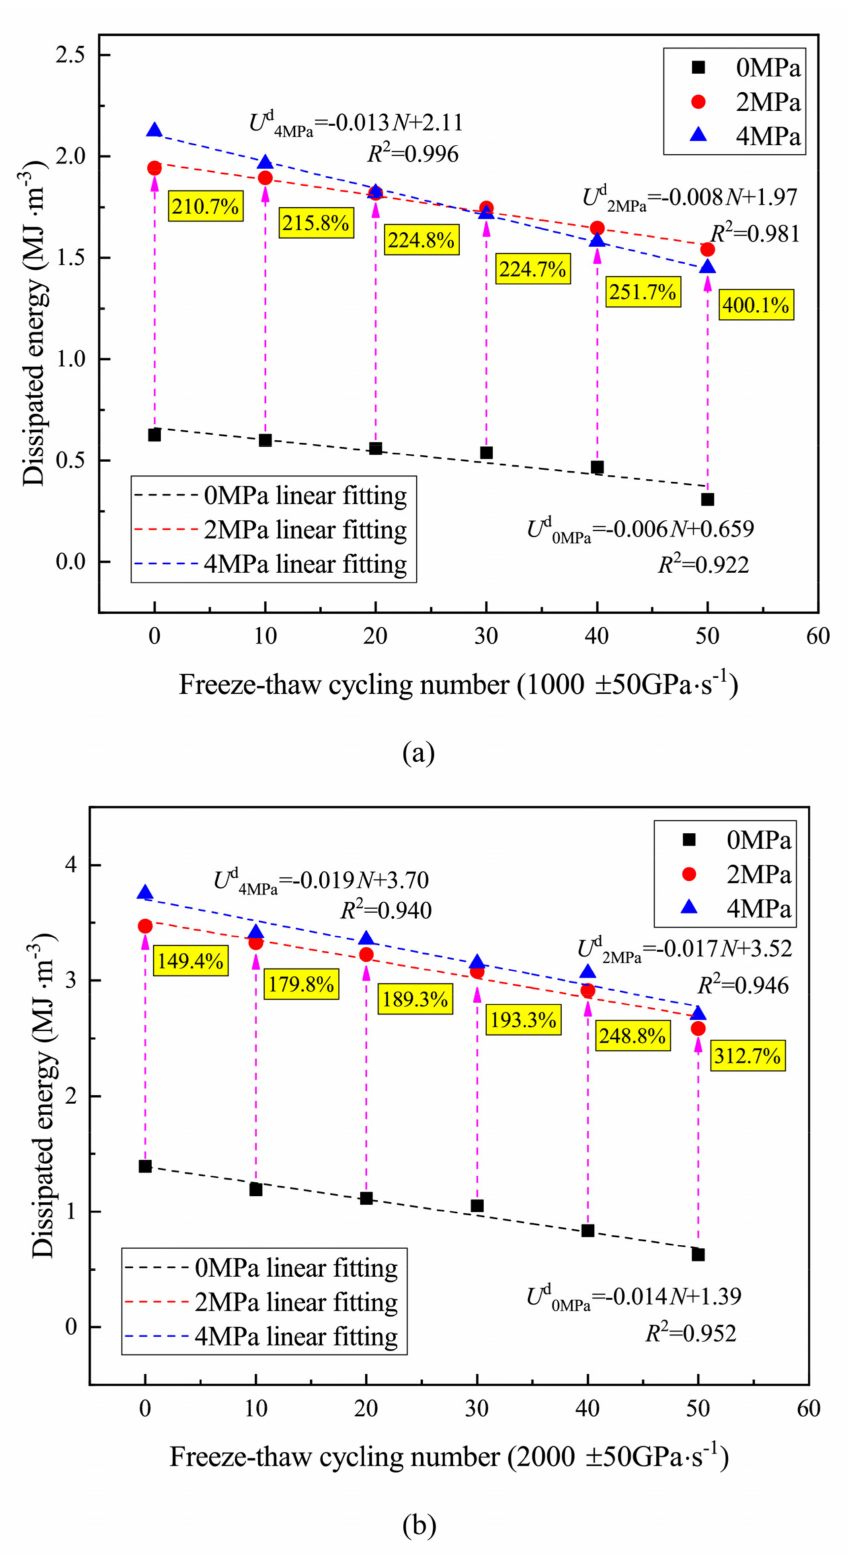
Figure 13. Dissipated energy varied with freeze–thaw cycling under a certain loading rate (1000 GPa/s and 2000 GPa/s) and different hydrostatic